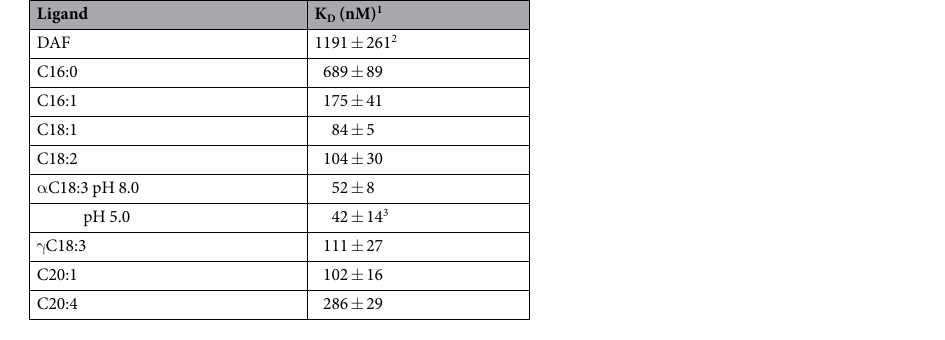
Table 1. Dissociation constants for binding of fatty acids to AeOBP22. 1 Values reported in nM and ± the standard deviation, n = 3. 2 n = 7. 3 n =